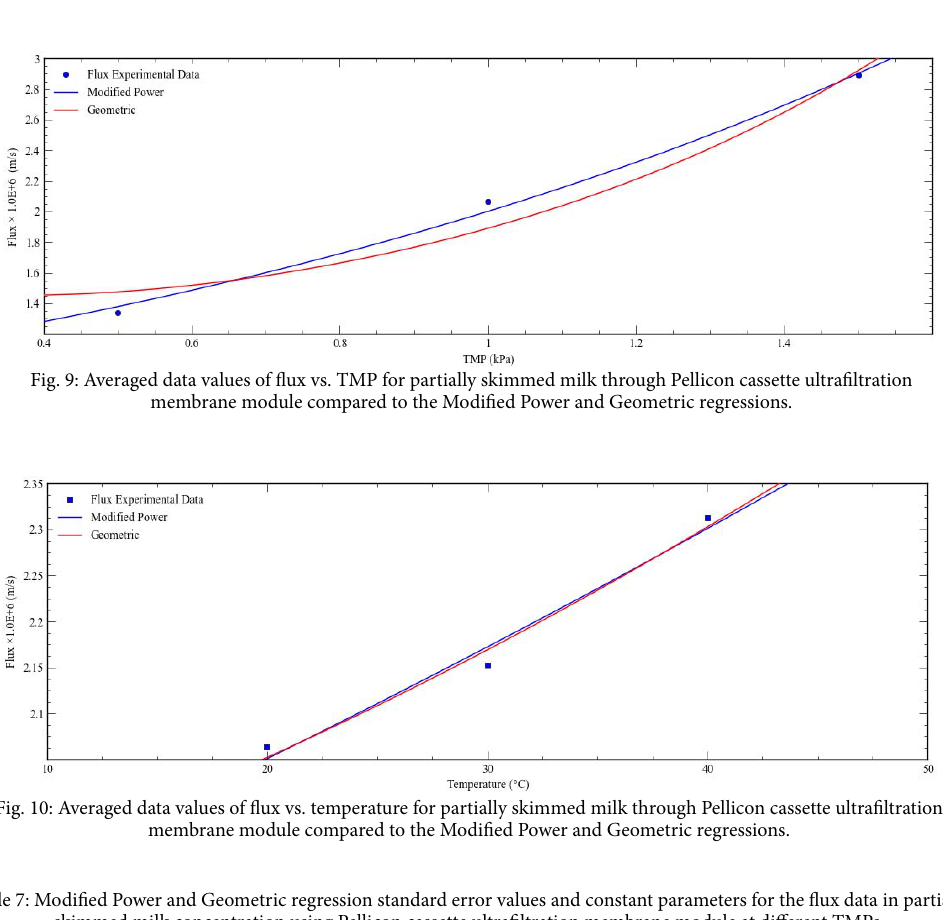
Regression Regression standard error